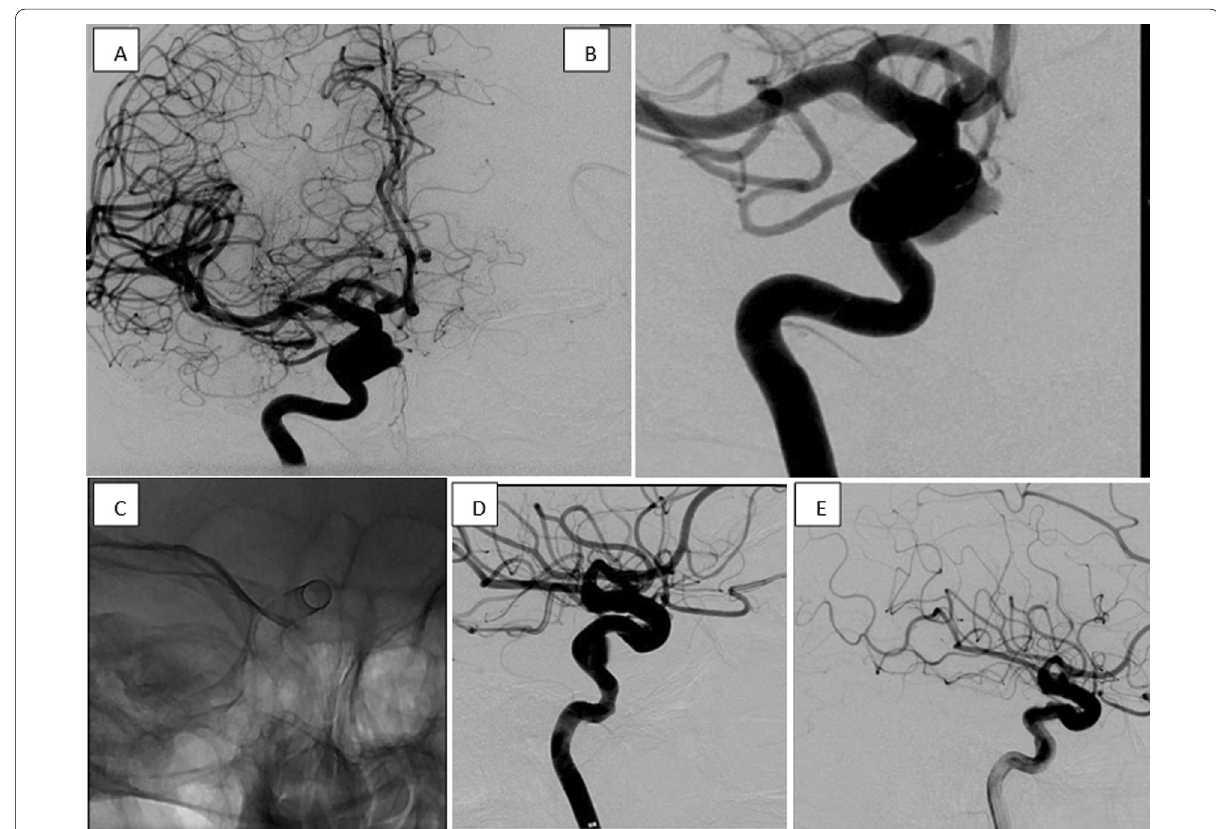
Fig. 2 Right carotid cavernous aneurysm with 16‑mm fundus and 5.4‑mm neck. A , B DSA anteroposterior and lateral views, right internal carotid artery. C Pipeline flow diverter 4.25